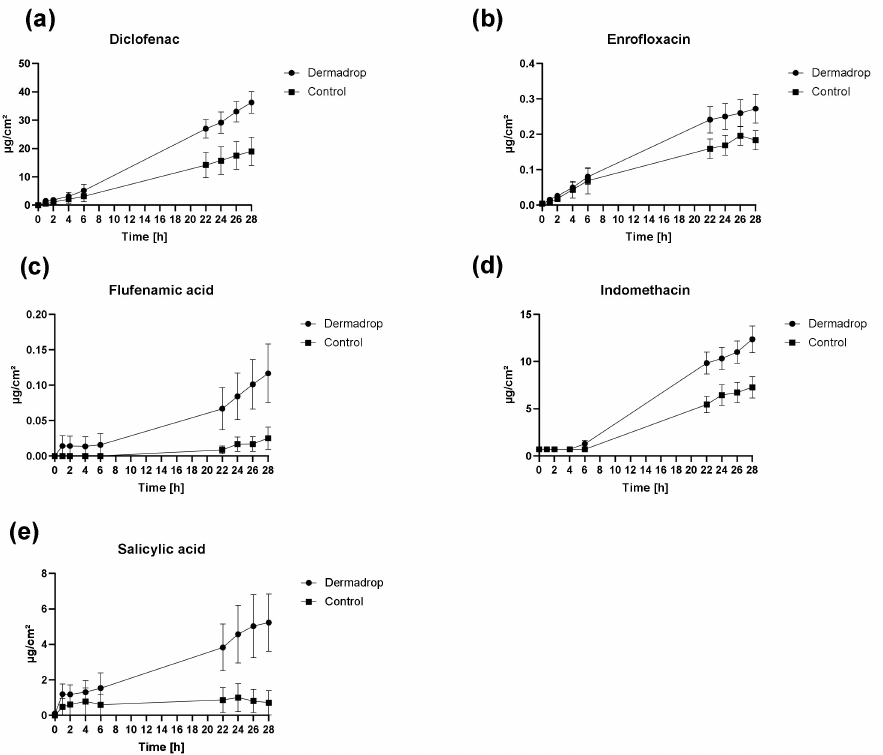
Figure 2. Cumulative amount of the different drugs after application via DERMADROP TDA and via pipette (control) over 28 h. ( a ) Diclofenac; ( b ) enrofloxacin; ( c ) flufenamic acid; ( d ) indomethacin; and ( e ) salicylic acid. Data are shown as mean ± SEM; n = 6.